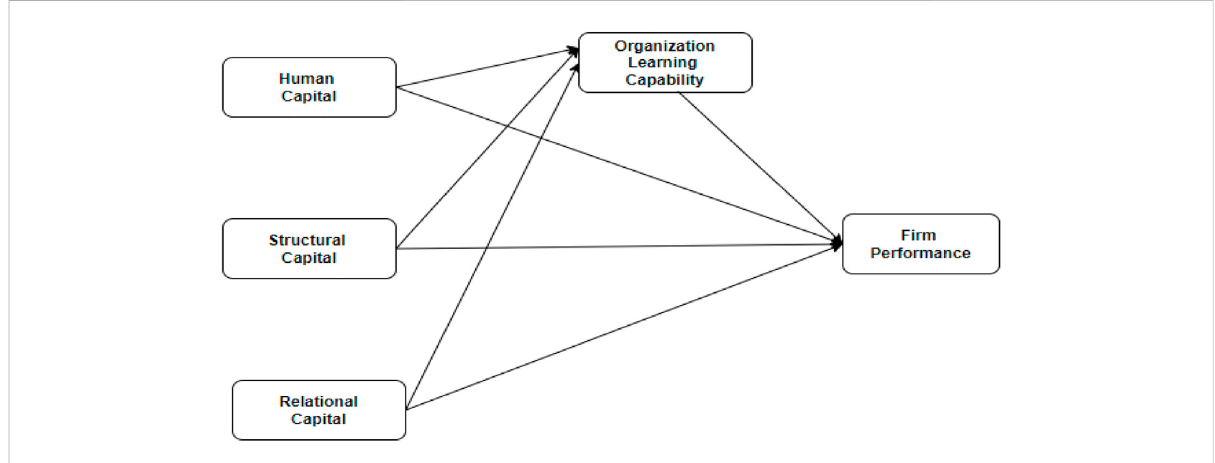
FIGURE 1 Conceptual framework